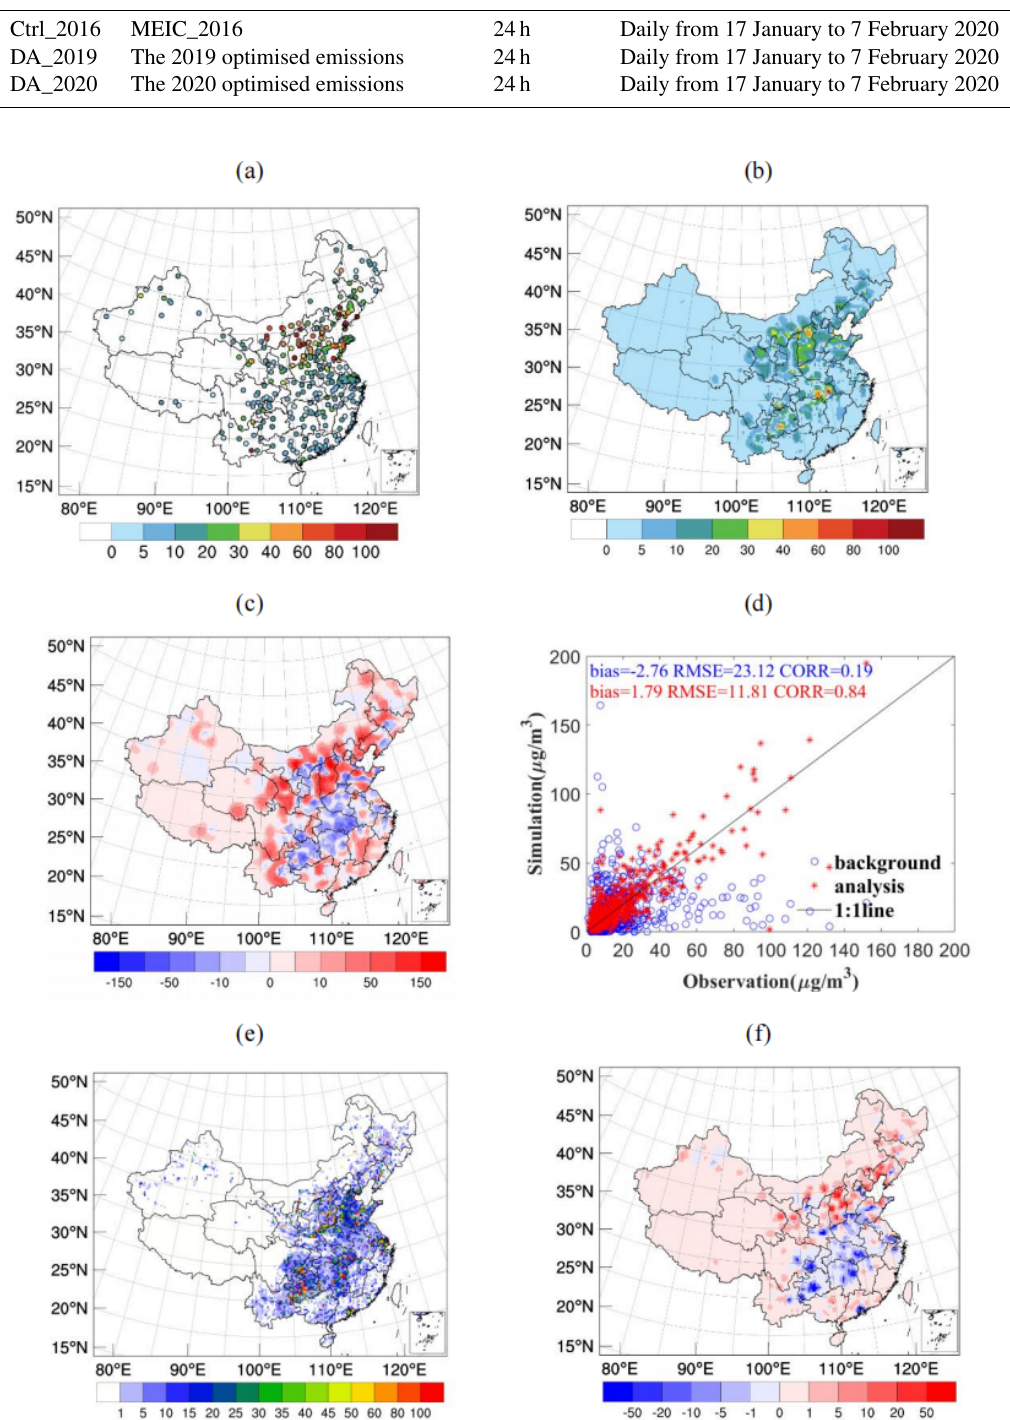
Figure 5. Simulated and observed SO 2 concentrations at 00:00UTC, 17 January 2019. (a) Observations, (b) background concentrations, (c) SO 2 concentrations increment, (d) scatter plots, (e) background emissions, and (f) SO 2 emissions increment. Units: µgm − 3 for (a)–(d) , andmolkm − 2 h − 1 for (e) and (f) . Insets: South China